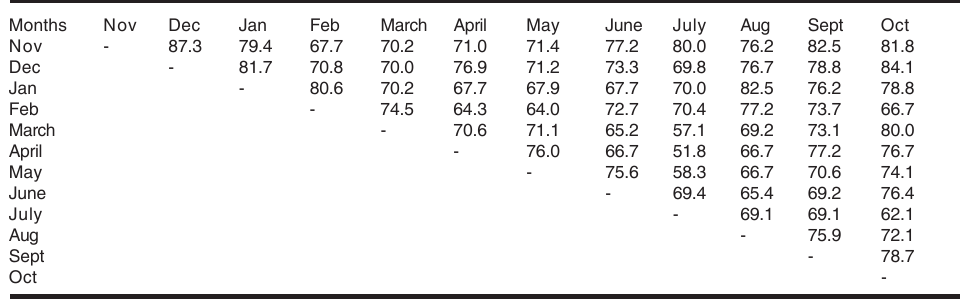
Table 4. Percentage similarities of microcrustacea (2003-04)